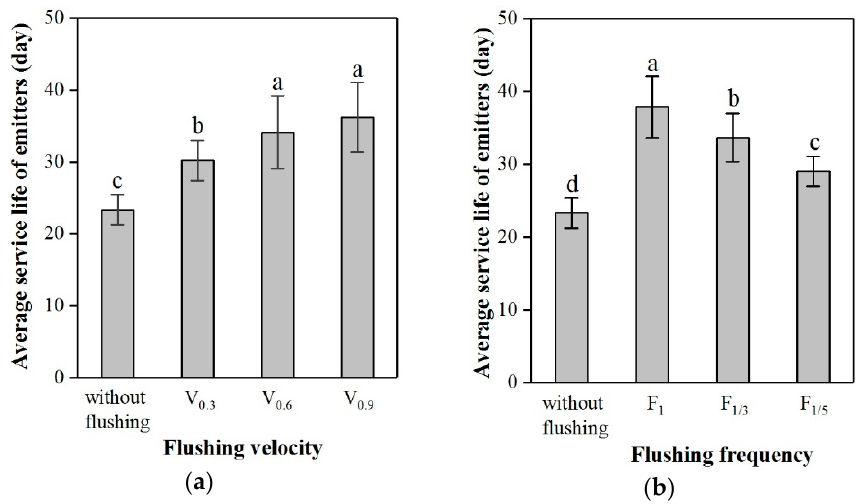
Figure 5. Average service life and standard errors of emitters at different flushing ( a ) velocities and ( b ) frequencies.